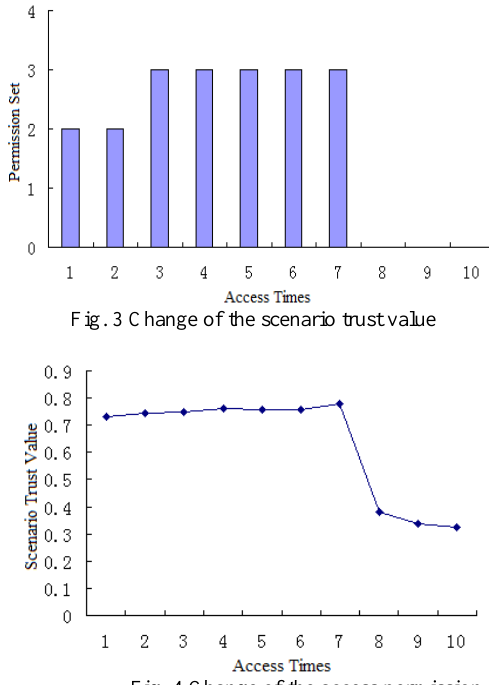
Fig. 3 Change of the scenario trust value